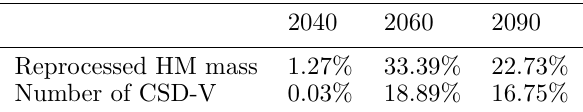
Fig. 11. CSD-V production according to reprocessing strategies. Table 6. Maximal variations on the cumulative repro- cessed HM mass and the cumulative CSD-V production over